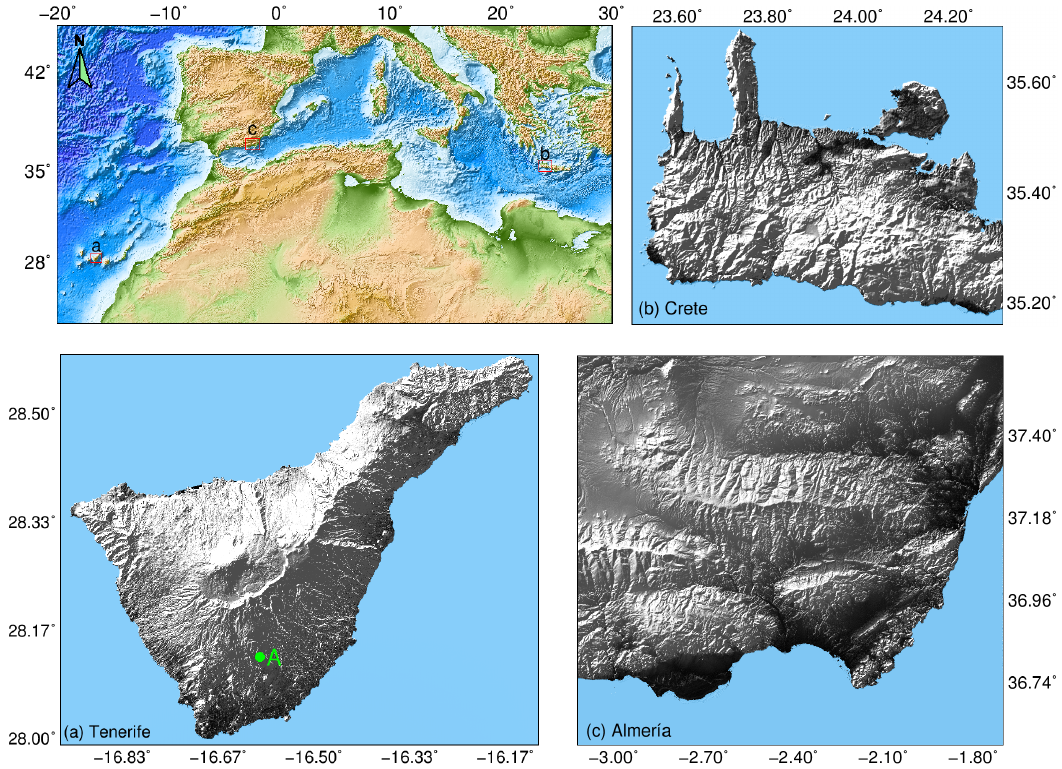
Figure 4. Overview of geographic locations of the test sites: Tenerife island, Spain, Almería, Spain, and Crete, Greece. ( a ), ( b ), and ( c ) show the local topography of each study